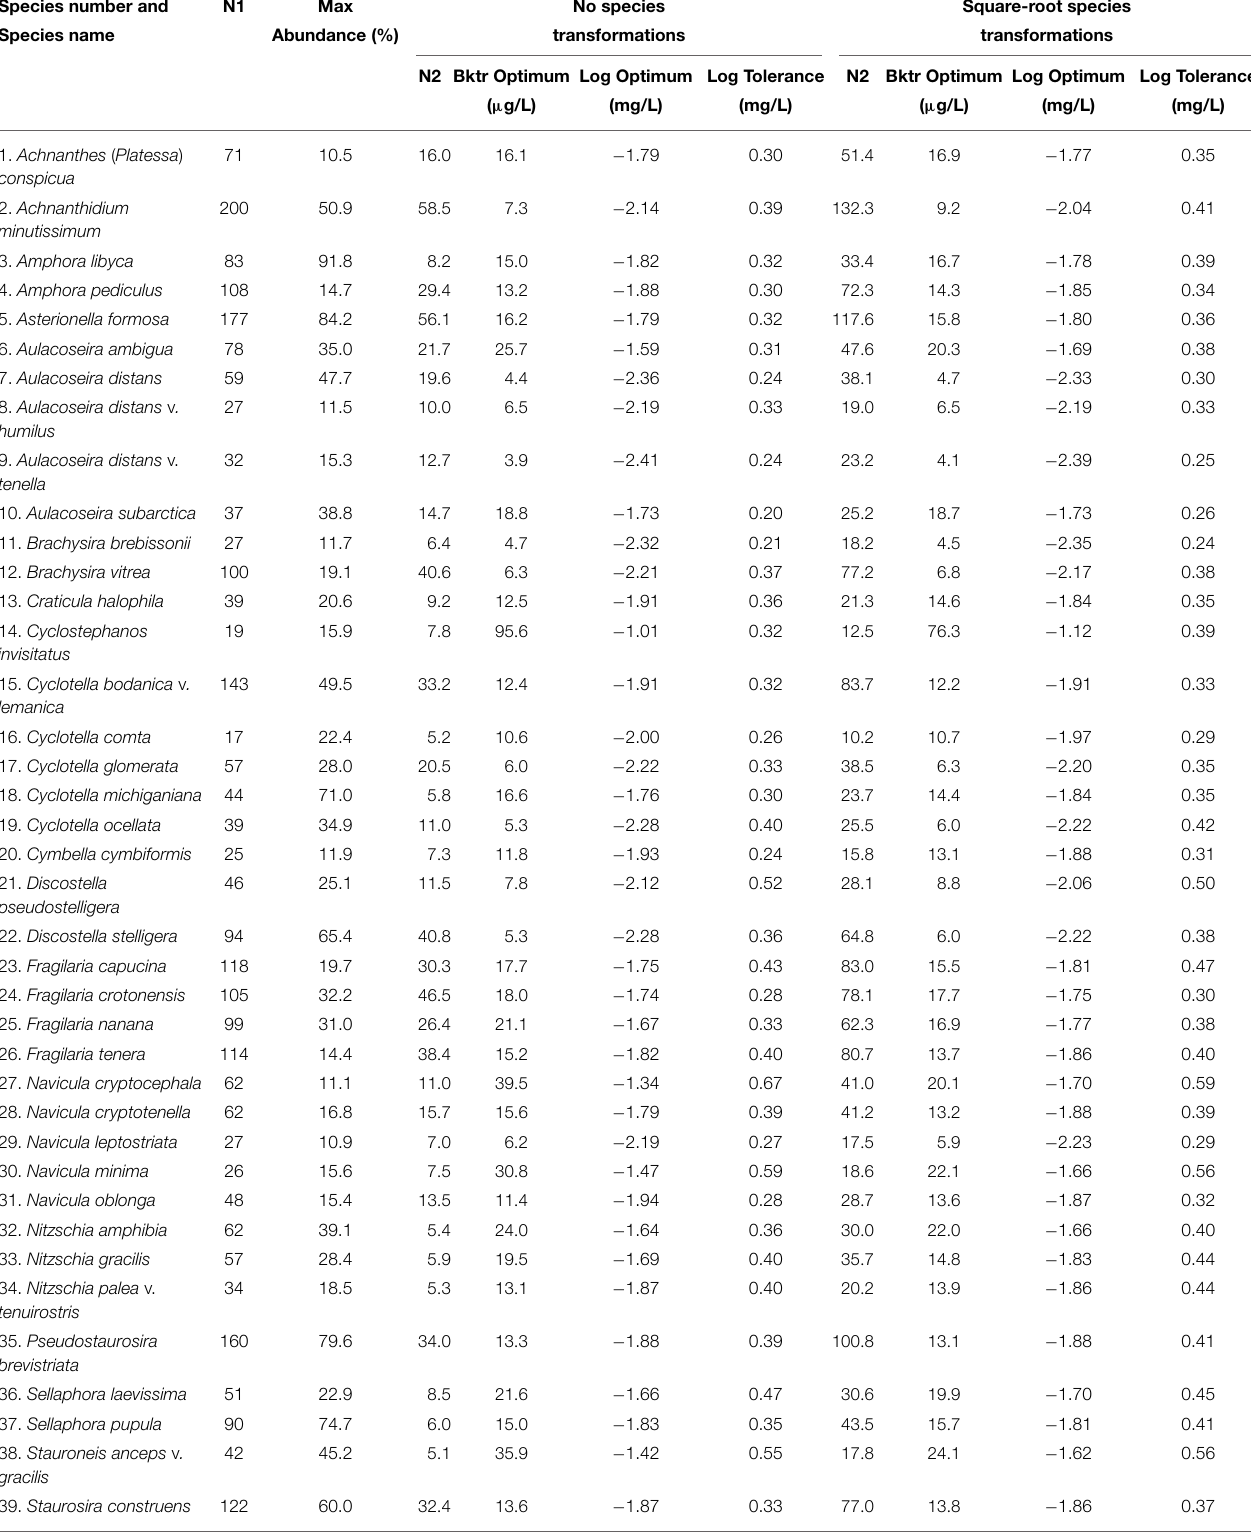
TABLE 2 | Estimates of simple weighted-average optima and tolerances for the dominant diatom taxa in the 251-lake calibration dataset, based on both untransformed and square-root transformed species data. Species number and N1 Max No species Square-root